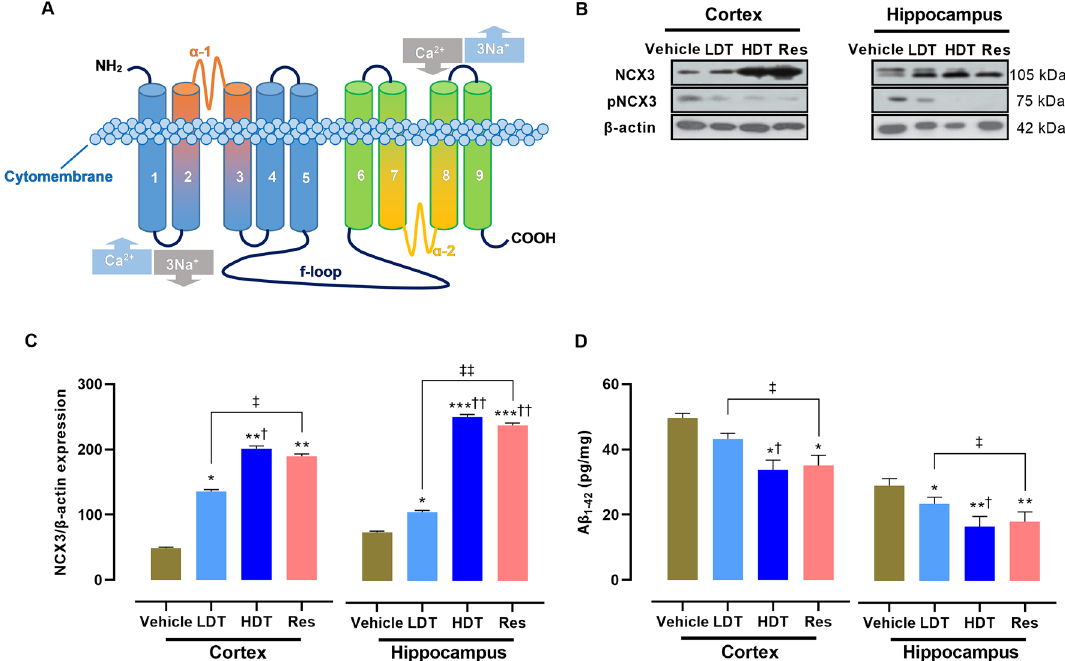
Figure 3. Neurochemical studies for the expression level of NCX3 and Aβ 1–42 in the cortex and hippocampus homogenates of 4-month-old 5xFAD mice after 45 consecutive days (P30-75) treatment with W. somnifera . ( A ) Schematic representation of NCX3 molecular pharmacology. ( B ) NCX3 expression normalized based on a β-actin loading control from the same immunoblot. ( C ) Quantitative analysis of the NCX3 immunoblotting. ( D ) Total Aβ 1–42 level. The cropped and full-membrane images of immunoblots are presented in Supplementary Figures S2 and S3. The data represent the mean ± SEM. Data were from 4 different mice in each group (n = 4 of two independent sessions) using one-way ANOVA followed by Tukey’s multiple comparisons test. Significance is indicated by * p < 0.05; ** p < 0.01; *** p < 0.001 versus vehicle; by † p < 0.05, †† p < 0.01 between W. somnifera treated groups; by ‡ p < 0.05, ‡‡ p < 0.01 between W. somnifera and Res treated groups. NCX3 Na + –Ca 2+ exchanger isoform 3, pNCX3 proteolytic fragment of NCX3, Vehicle control group, LDT low dose treatment, HDT high dose treatment, Res